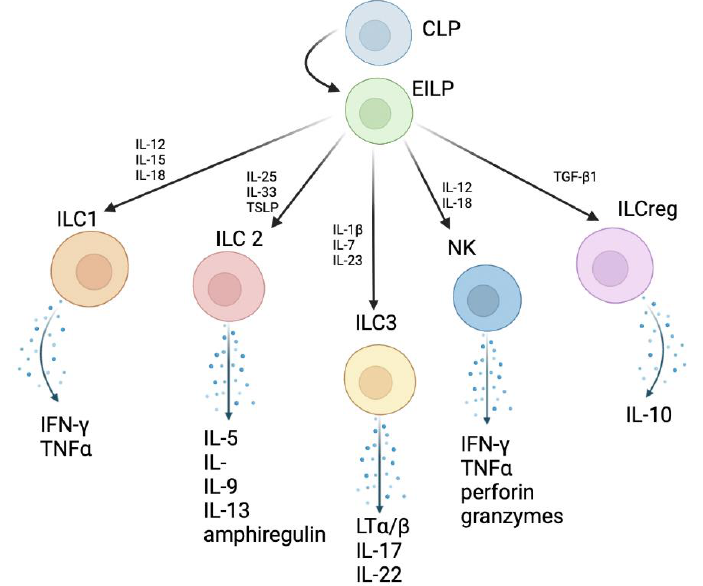
Figure 1. Distinction of each group of ILCs on the basis of cytokines stimulating their specialization and cytokines released by each ILC type. ILCs develop from common lymphoid progenitor cells (CLP) to early innate lymphoid progenitor cells (EILP), which are common and early innate lymphoid cells that are acted upon by varying cytokines to aid in the development of ILC1, ILC2, ILC3, ILCregs, and NK cells. Now specialized, these cells will release cytokines involved in inflammatory processes. The major cytokines involved in these processes are listed above [14,15].